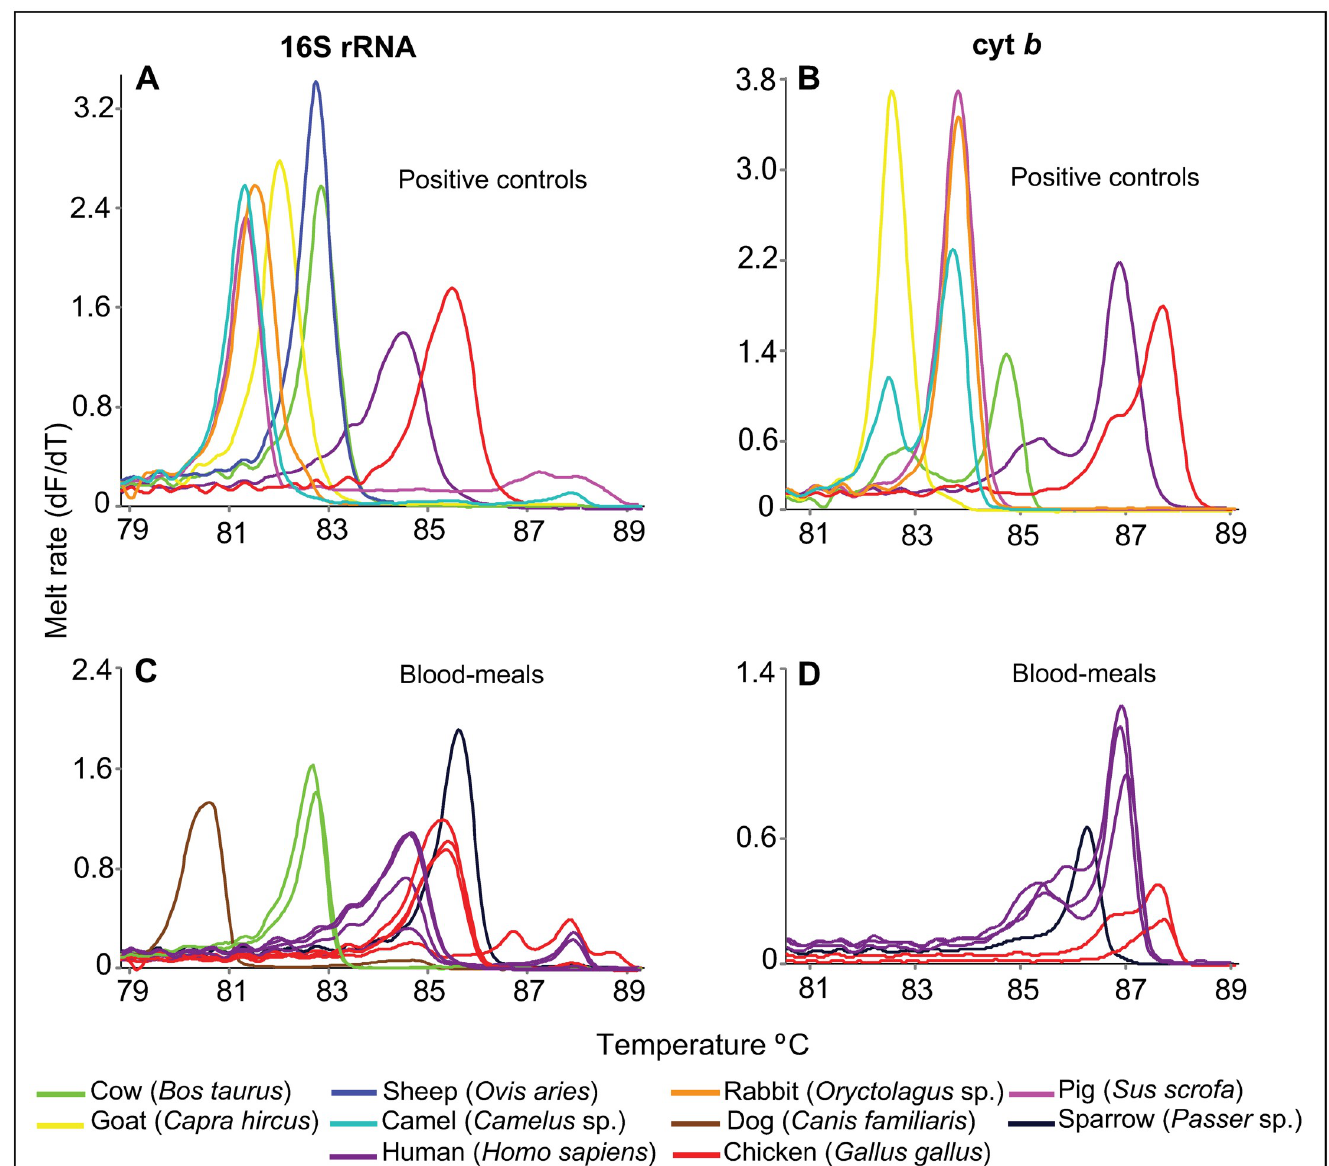
Fig 3. Melt rate profiles of resolved blood-meal sources from mosquitoes sampled at selected hospitals in Busia, Bungoma, and Kakamega counties. Each panel is composed of mixed curves from several controls and blood-meal samples. Amplification of (A) 16S rRNA and (B) cyt b markers in positive controls. Amplification of (C) 16S rRNA and (D) cyt b markers in positive